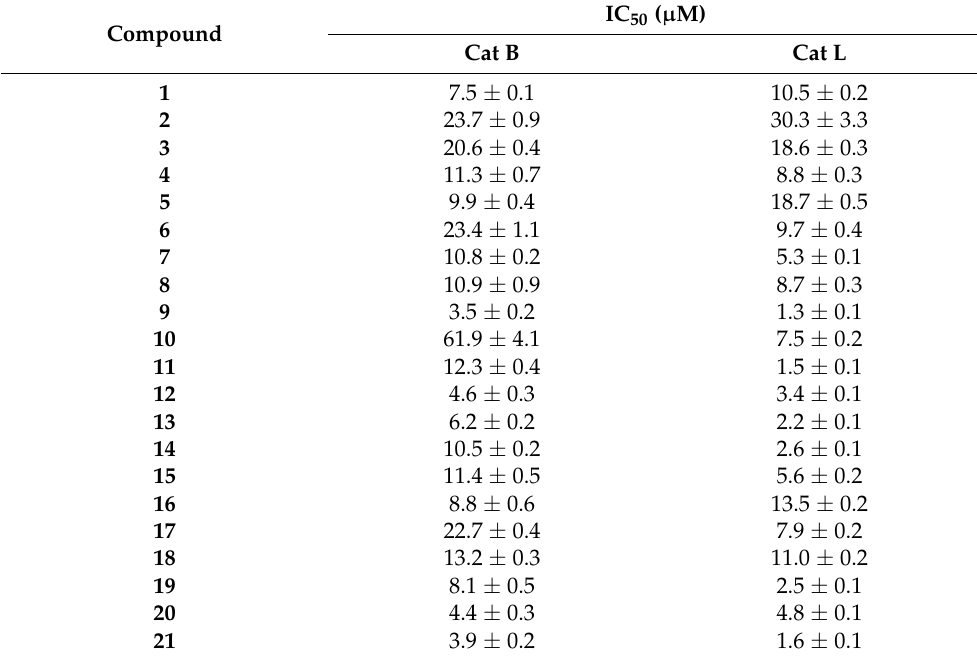
Table 2. Determination of IC 50 values of alkylphospholipids and alkyltriazoles in the inhibition of cathepsins B and